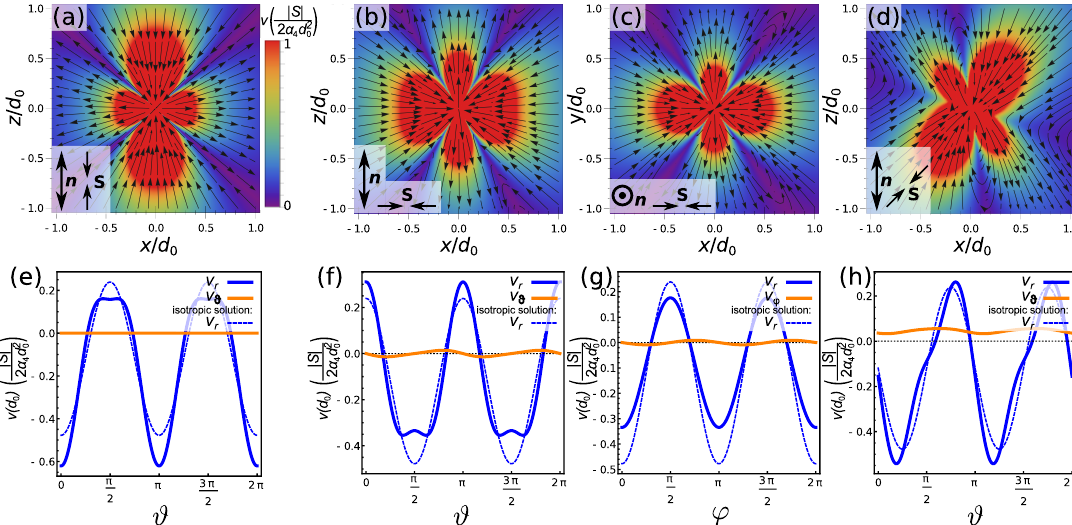
Figure 3. Flow field of a force dipole at different orientations with respect to the director field. The bottom row shows radial and azimuthal (or polar) component of the velocity at distance d 0 from the centre as a function of azimuthal (or polar) angle compared to the result for isotropic fluids. ( a , e ) flow field of force dipole aligned with the director has only radial component. Note that radial flow field is characteristic for dipolar flow in isotropic fluids; however, in nematic fluids, there is still a difference between the magnitudes of the flow field between the isotropic case and a dipole aligned along the director due to anisotropic viscosity (see, e ). In ( a , e ), the magnitude of the velocity field falls to zero at angle θ = 48.3 ◦ , whereas, in the isotropic case, the transition from inward to outward flow occurs at θ = 54.7 ◦ . At ( b , c , f , g ) 90 ◦ or ( d , h ) 45 ◦ , angles between force dipole and the director before radial flow configuration gains additional terms in the azimuthal and polar